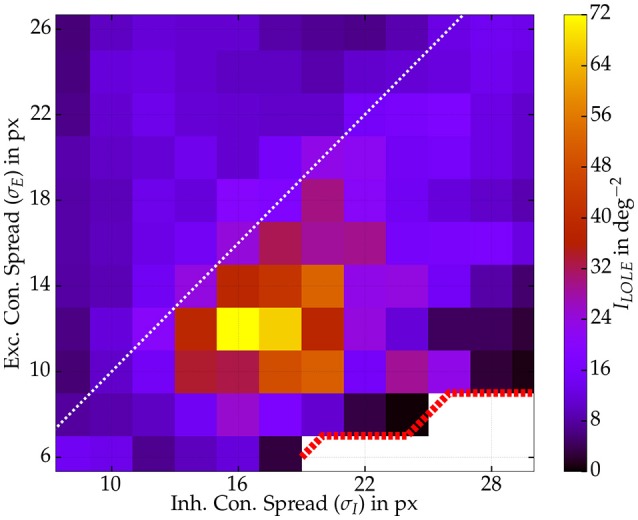
Fisher information ILOLE as a function of both connection widths σI and σE. One network per spread combination with recurrent strengths of ḡEE = 0.4 nS and ḡIE = 0.6 nS. Some Mexican hat networks with very narrow σE led to self-sustained activity (white area, red dotted border) and were excluded from the analysis. Values were computed from 125 excitatory neurons and 125 repetitions per stimulus (s ∈ {−1°, 1°}). Maximum input firing rate was 30 Hz.